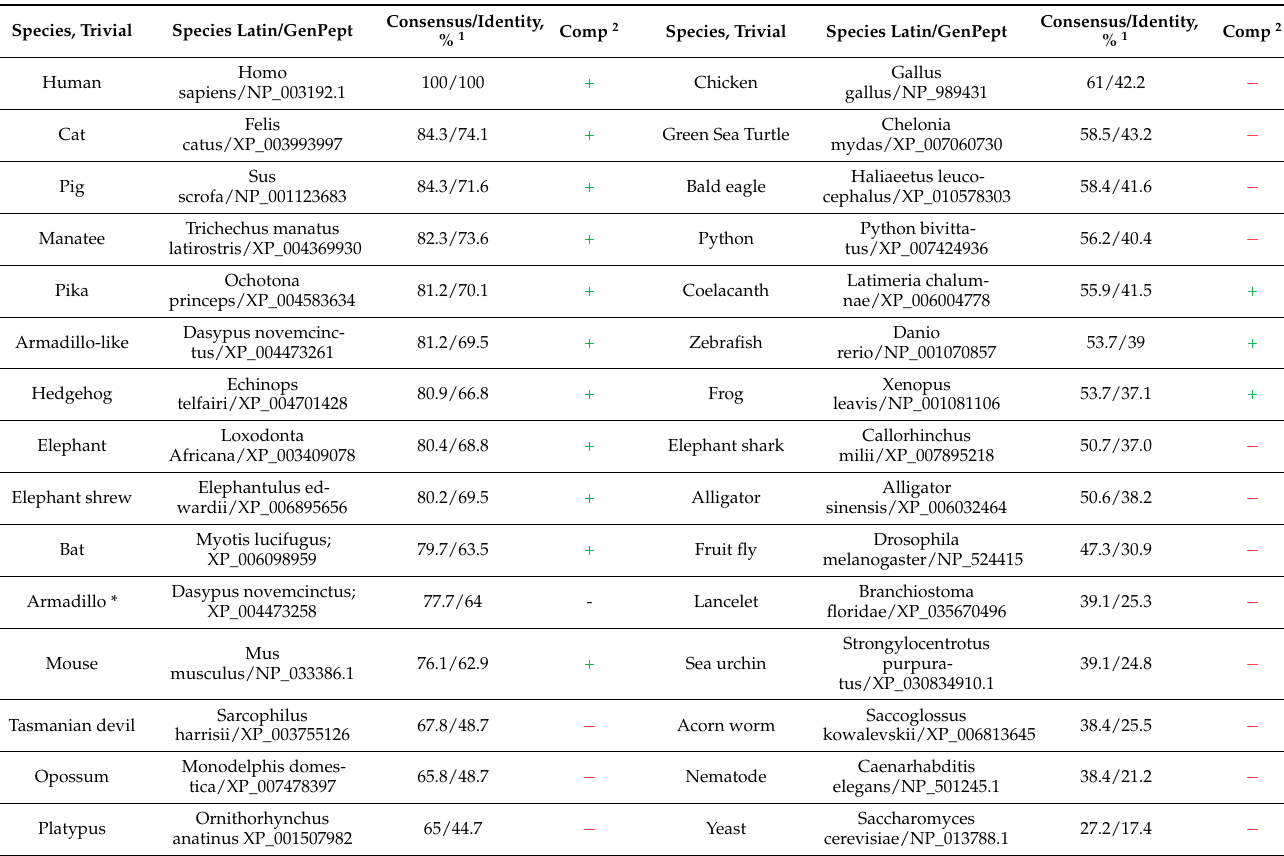
Table 1. Replication of the human mtDNA by TFAM